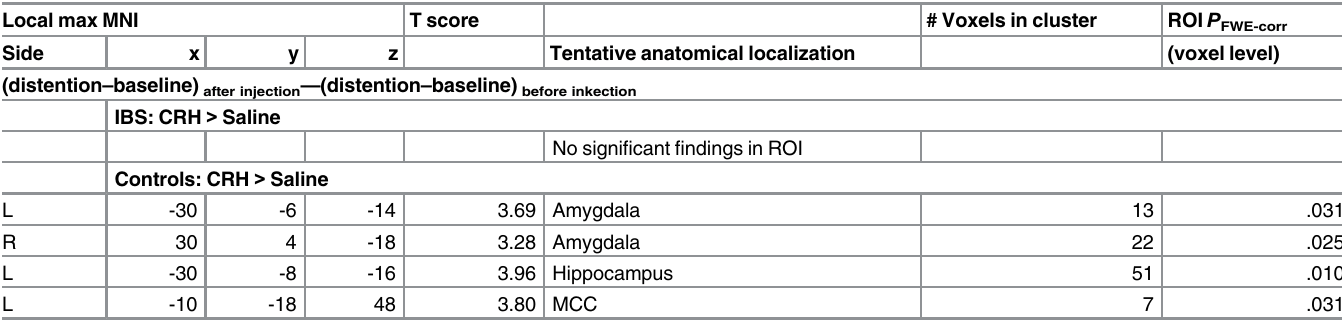
Table 1. Effect of CRH on brain activation in response to colonic distentions. Local max MNI T score # Voxels in cluster ROI P FWE-corr Side x y z Tentative anatomical localization (voxel level) (distention – baseline) after injection — (distention – baseline) before inkection IBS: CRH > Saline No signi fi cant fi ndings in ROI Controls: CRH >